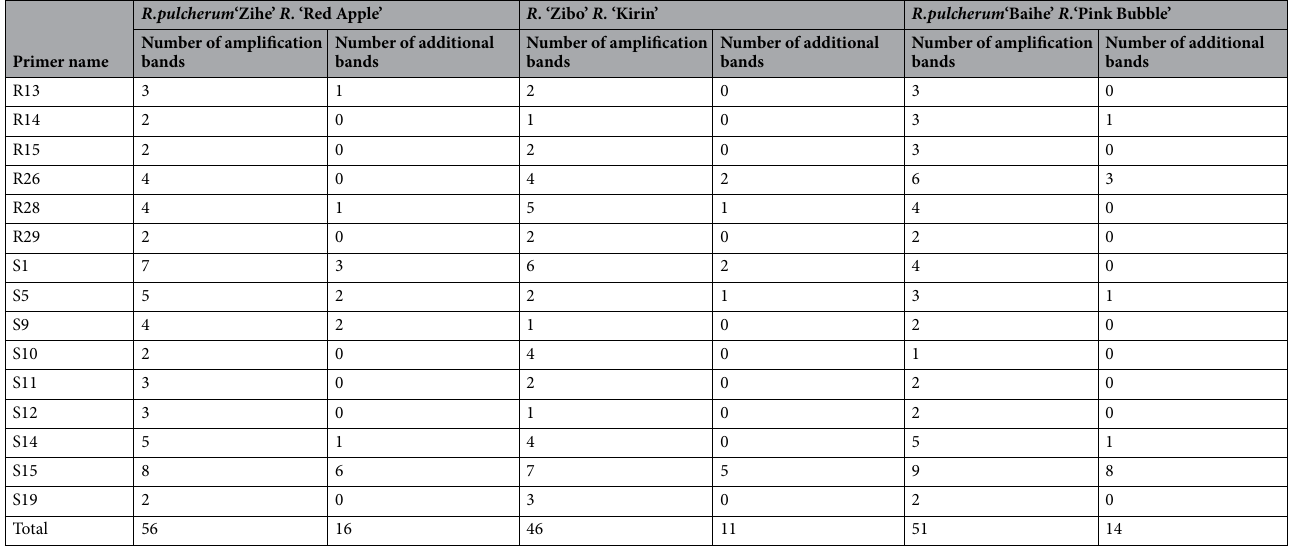
Table 7. The bands of different combinations of